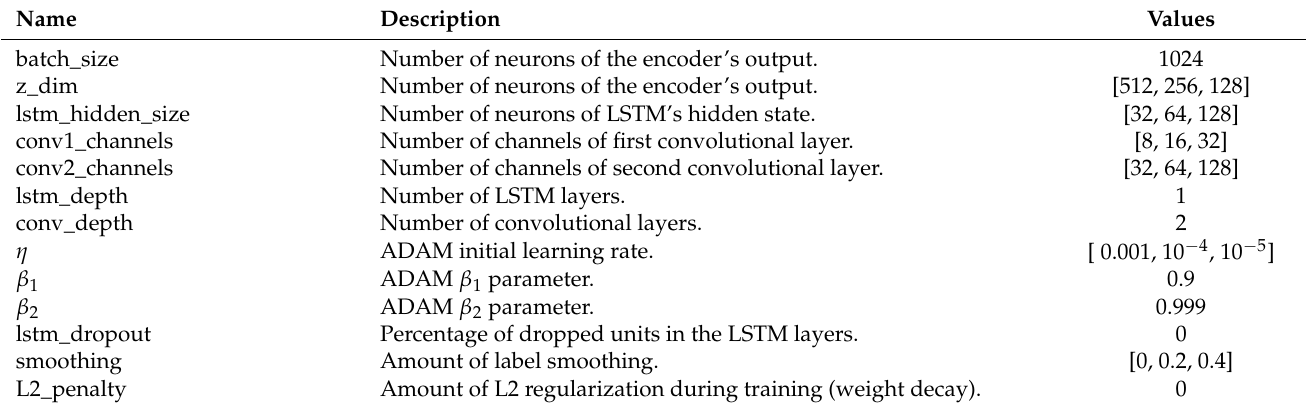
Table 3. Grid of hyperparameters taken into consideration during